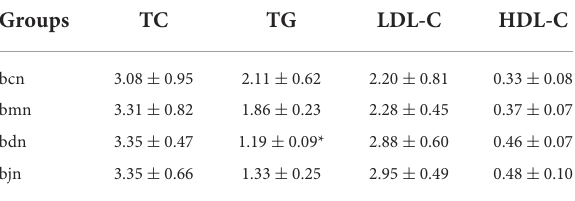
TABLE 1 Effects of DO on serum biochemical indexes of mice with high-fat die (mmol/L). Groups TC TG